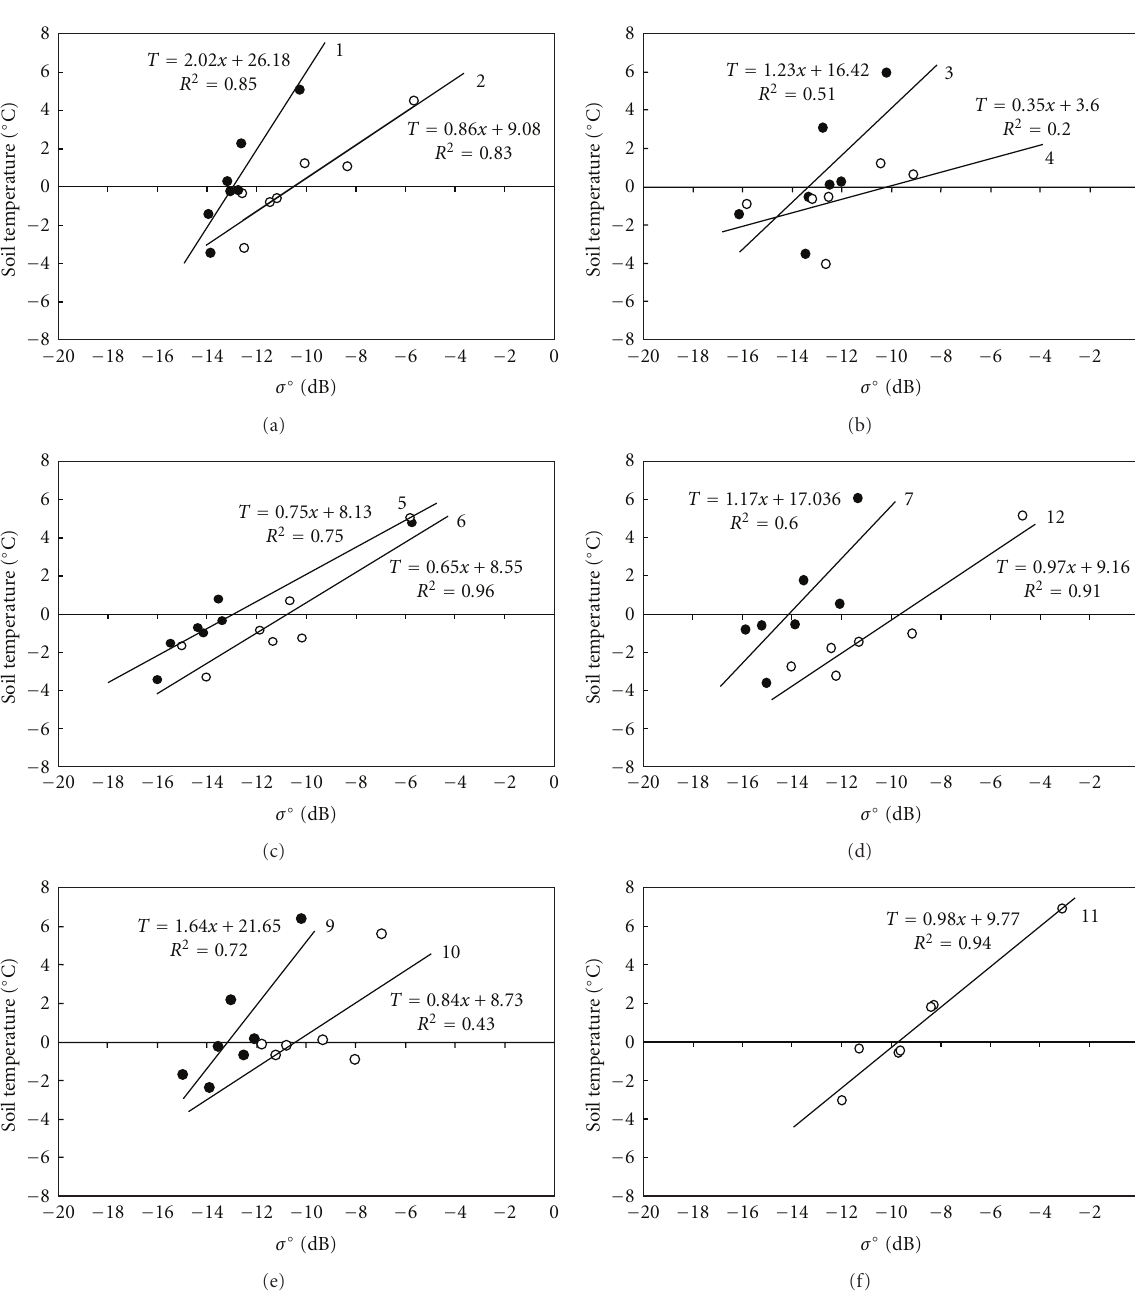
(untilled versus tilled fields) during the same winter